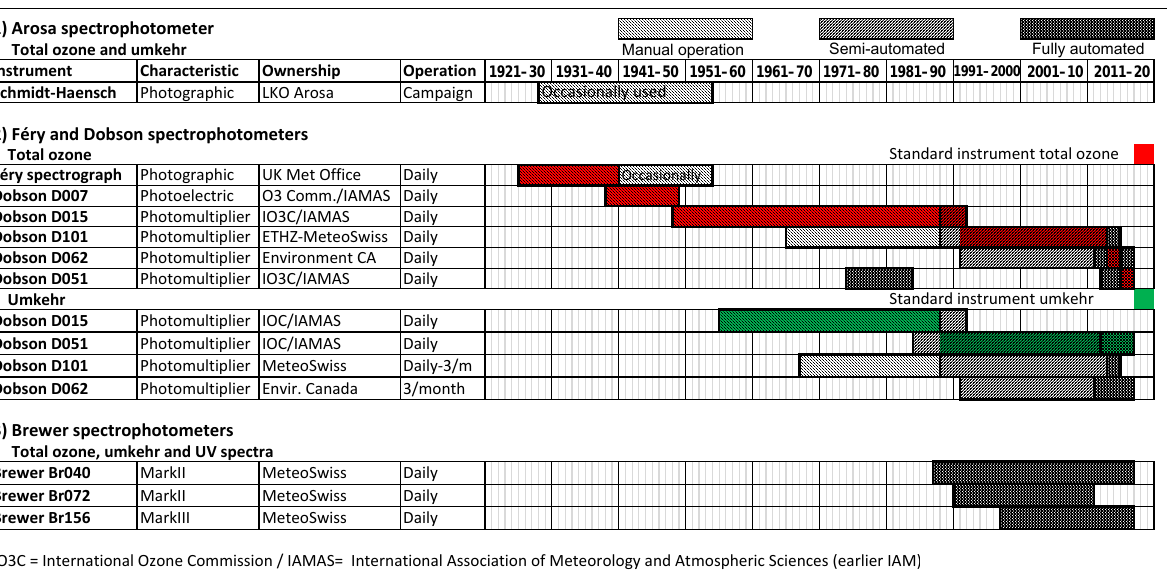
Figure 4. Sun photometers used at LKO from 1926 to present. The “Arosa spectrophotometer” is a Fabry Buisson-type spectrograph built in 1926–1928 by the Schmidt–Haensch (Berlin) company from a design supervised by Götz. It was only occasionally used. Regular ozone measurements at LKO were instead made with instruments designed by Dobson. Initially, a photographic Féry spectrograph was used, while subsequent instruments were double monochromator spectrophotometers (detection: photoelectric or photomultiplier). The D101 instrument has been installed at Davos since January 2016. The Brewer spectrophotometers are single grating monochromator (Br40 and Br 72 MarkII) or double grating monochromator (Br156 MarkIII) systems. From November 2011–March 2013 Br72 was operated in Davos and again since June 2014. For more details see Staehelin and Viatte